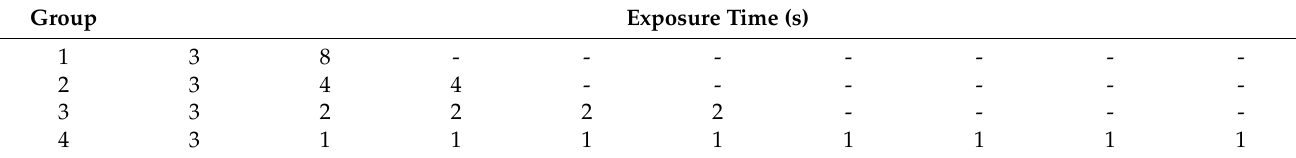
Table 4. The curing strategies.